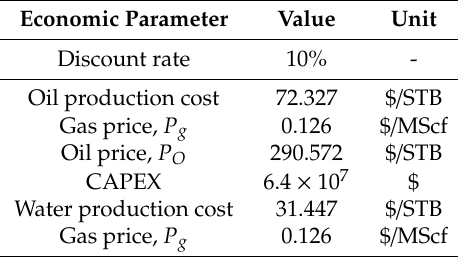
Table 3. Economic parameters used by authors in well placement